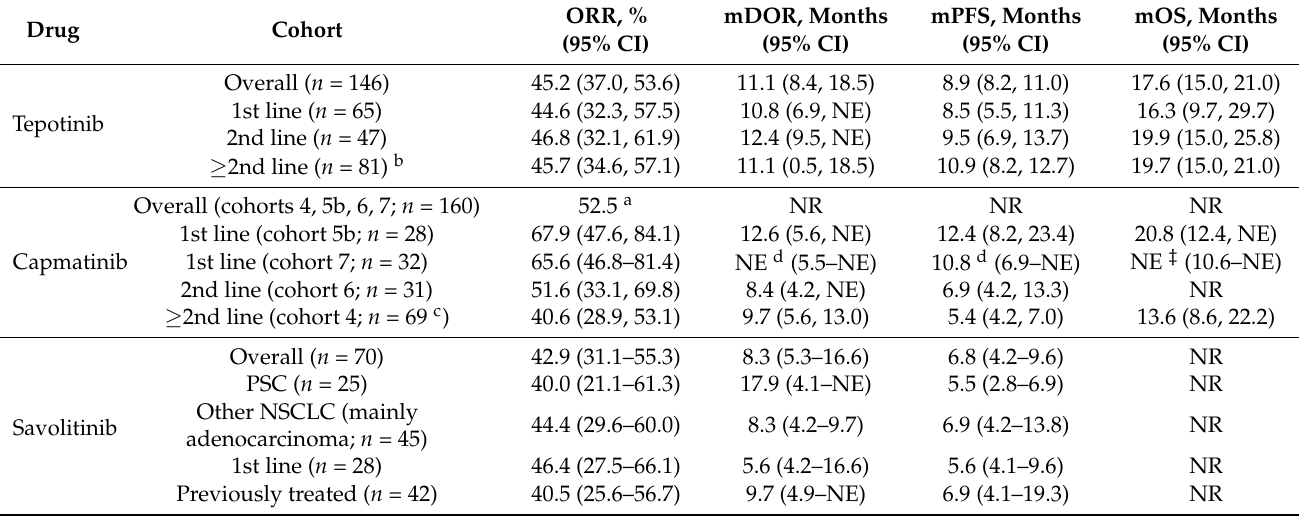
Table 2. Efficacy of Type Ib MET inhibitors in metastatic NSCLC with MET ex14 skipping mutations.